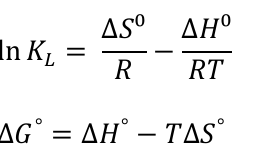
posite at different